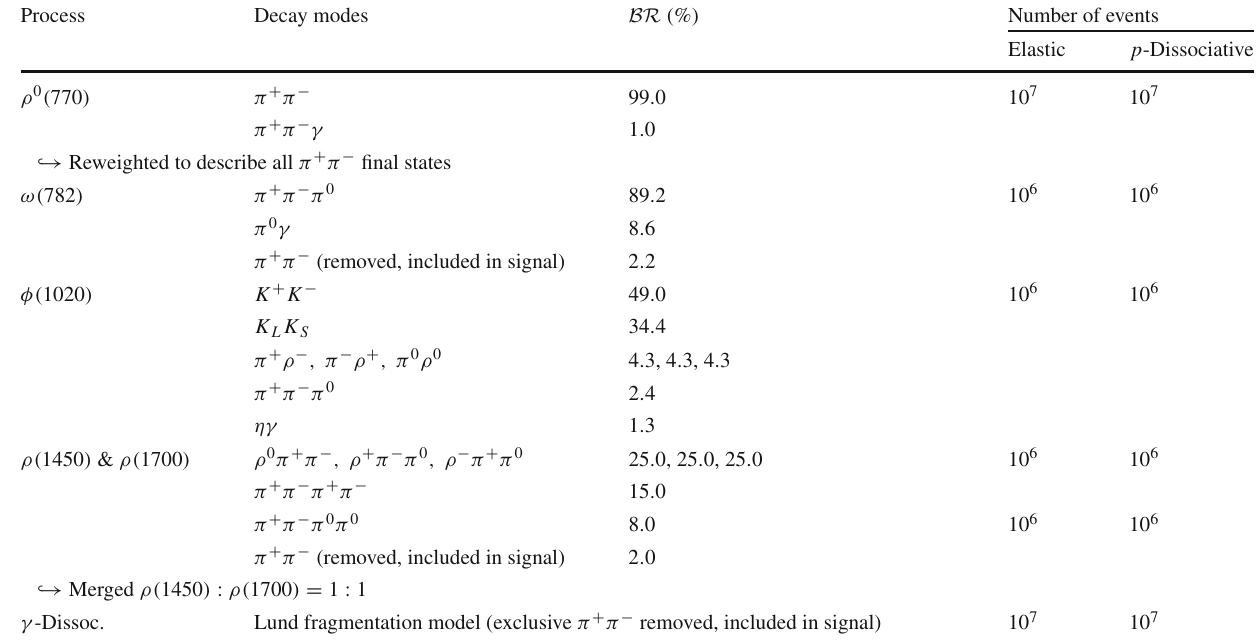
Table 2 DIFFVM MC samples used to model the π + π − photopro- duction dataset. All decay modes with a branching fraction (cid:3) 1% are simulated [47]. For the ρ( 1450 ) and ρ( 1700 ) samples a ratio of 1:1